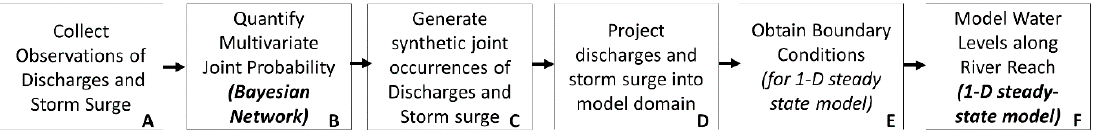
Figure 1. Schematic workflow for generating stochastic water surface profiles in a coastal catchment.